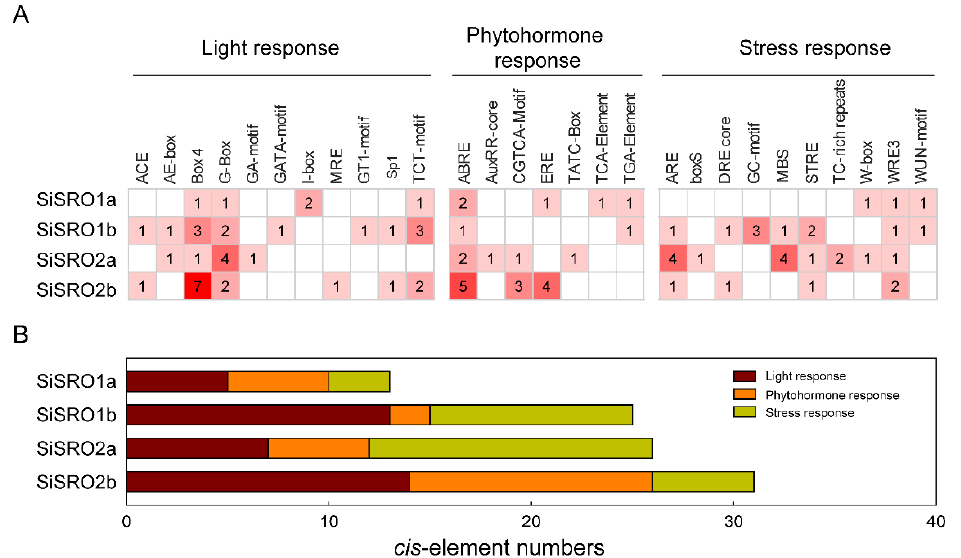
Figure 4. Predicted cis elements in the promoter regions of SiSRO genes. ( A ) Number of each cis element in the promoter region of SiSRO genes. Based on the functional annotation, the cis elements were classified into three major categories: light responsiveness-, phytohormone-, and stress-related cis -acting elements. The cis elements and their descriptions are listed in Table S2. ( B ) Sum of the cis elements in each gene and category.